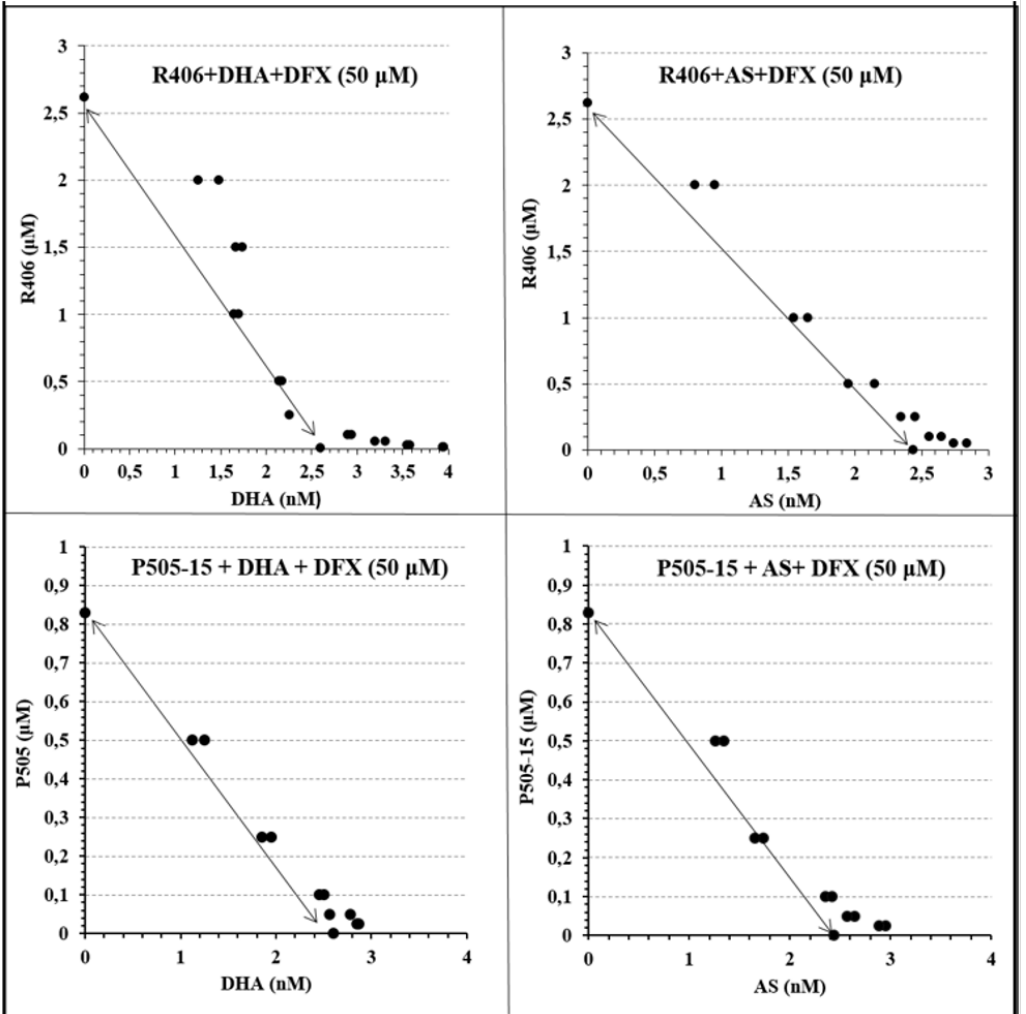
Figure 7. Isobolograms showing the interactions between Syk Inhibitors (P505-15 and R406) and dihydroartemisinin (DHA) and artesunate (AS) in combination with the iron chelator Deferasirox (DFX), after 24 h of incubation in the P . falciparum Palo Alto strain. Synchronized P. falciparum cultures were treated for 24 h with different concentrations (from 0.05 to 2.5 µM) of representative Syk inhibitors (P505-15 and R406) in combination with different concentrations of DHA and AS (from 0.6 to 10 nM) using a fixed concentration (50 µM) of the iron chelator Deferasirox (DFX) at the ring stage.